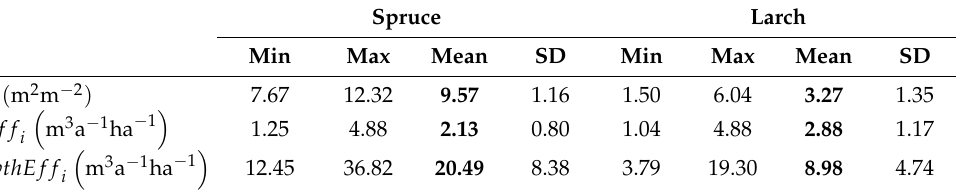
Table 5. Leaf area indices (LAI) and efficiencies (LA eff is the leaf area efficiency, i.e., increment per leaf area, and Growth eff is growth efficiency, i.e., growth per available stand area of the species). SD is the standard deviation. Spruce Spruce Larch